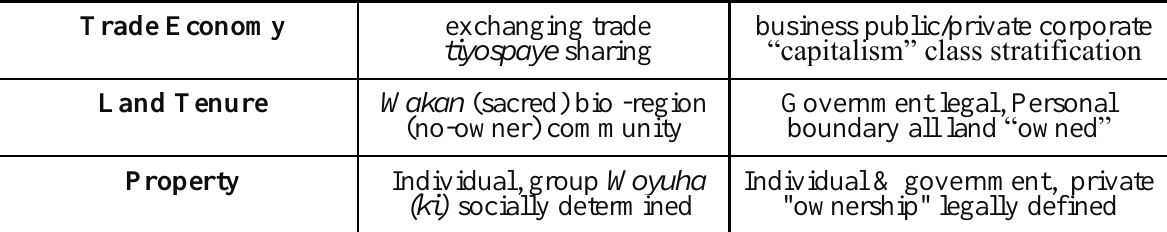
Table 1D. Economy Social Sphere